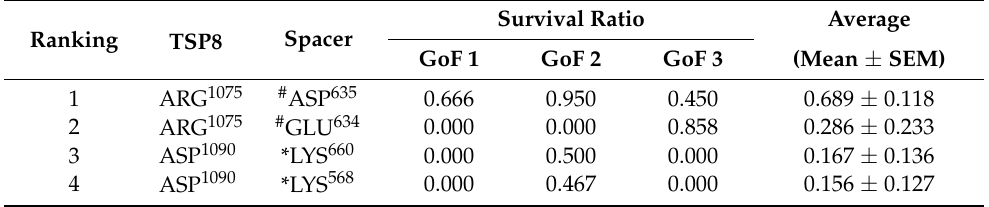
Figure 5. Three FMD simulations of the GoF complex. ( A ) Variation of Cα -RMSD with time for GoF1 (blue), GoF2 (magenta), and GoF3 (green) . The Cα -RMSD fluctuated smoothly in a range of 1 Å when the time exceeded 30 ns; ( B ) Gaussian fitting of the N HB frequencies of three GoF complexes (R 2 > 0.98). The heat maps of the survival ratios of H-bonds ( C ) and ( D ) salt bridges on the interface of the GoF complex. * Indicates residues in exosite-3 of the Spacer domain, and # indicates residues in exosite-4 of the Spacer domain. Table 6. The salt bridges on the interface of the GoF complex with an average survival ratio >10%. Ranking TSP8